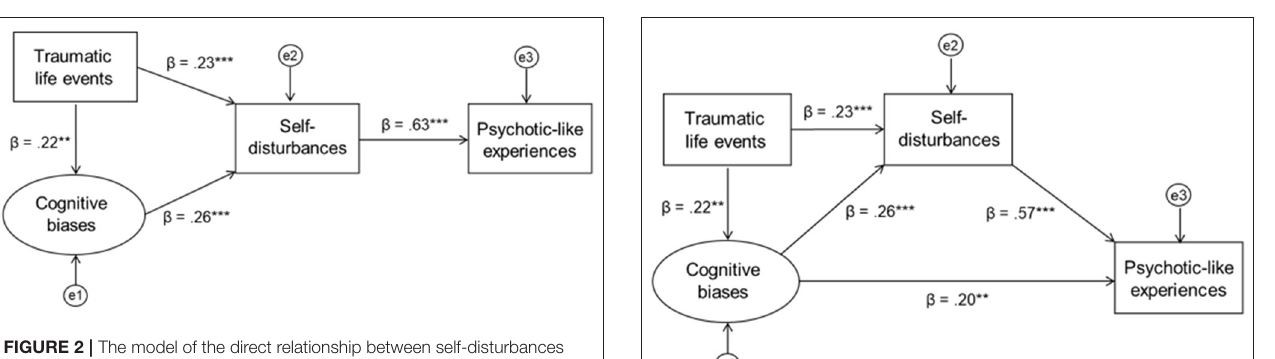
FIGURE 2 | The model of the direct relationship between self-disturbances and psychotic-like experiences with childhood trauma and self-report cognitive biases as the potential contributors to self-disturbances.